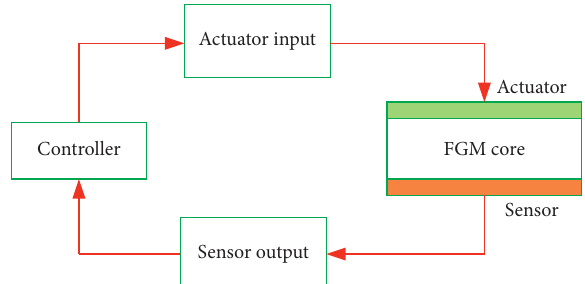
Figure 2: The vibration control model of the plate by the piezo- electric